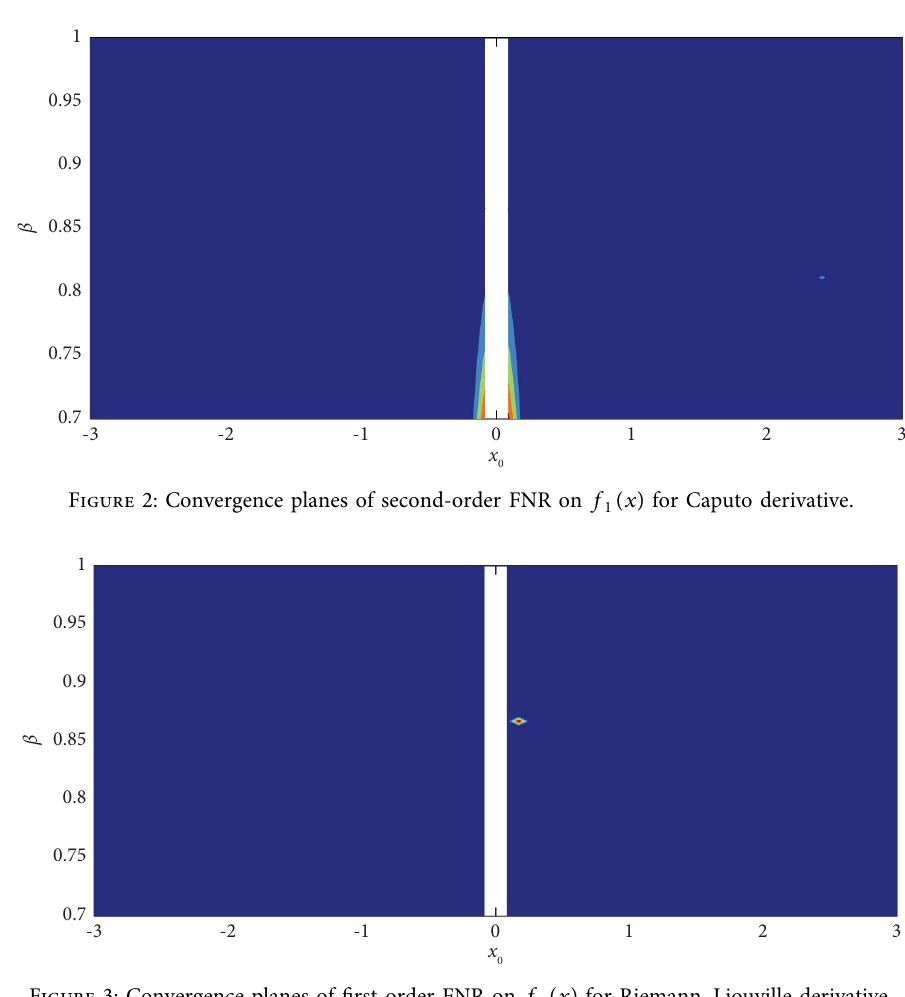
( x ) for Riemann–Liouville 1